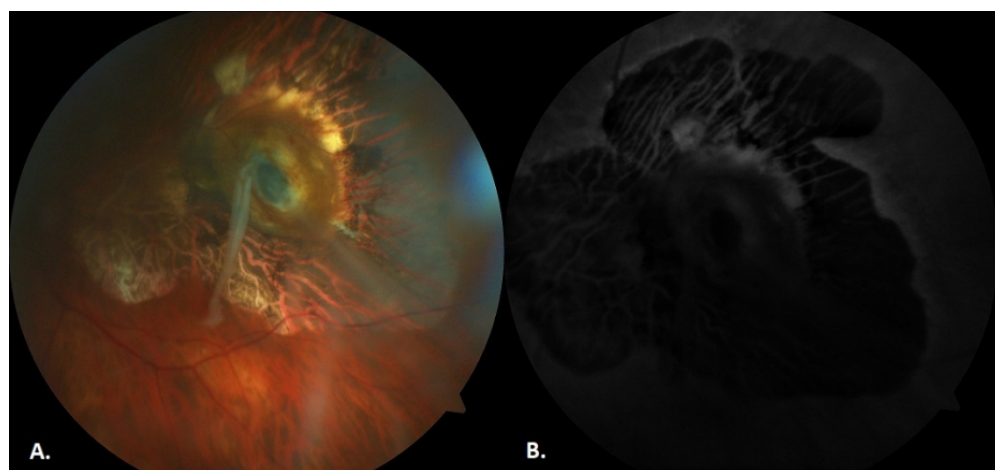
Figure 1: A. Fundus image shows pigmented and elevated lesion on the paramacular area, surrounded by diffuse atrophy. B. Fundus autofluorescence image shows a wide hypoautofluorescent area due to the RPE atrophy with regular borders and hyperautofluorescence along the margin of the lesion.